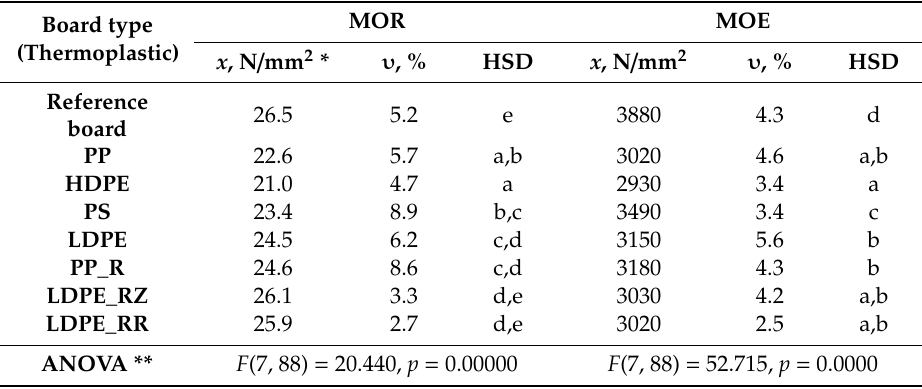
Table 3. The e ff ects of thermoplastics on bending strength and modulus of elasticity. Board